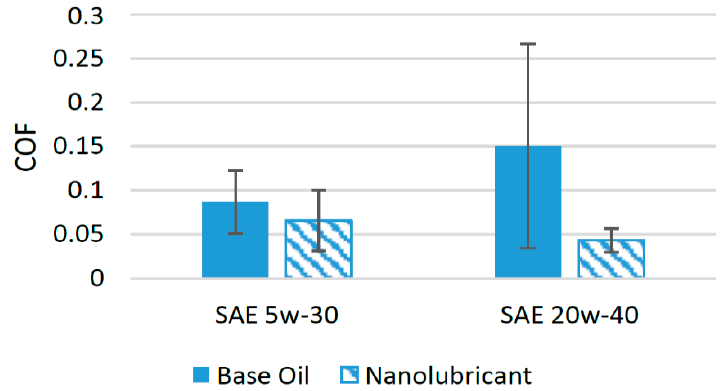
Figure 11. Effect of Al 2 O 3 NPs on the friction performance of synthetic lubricants.